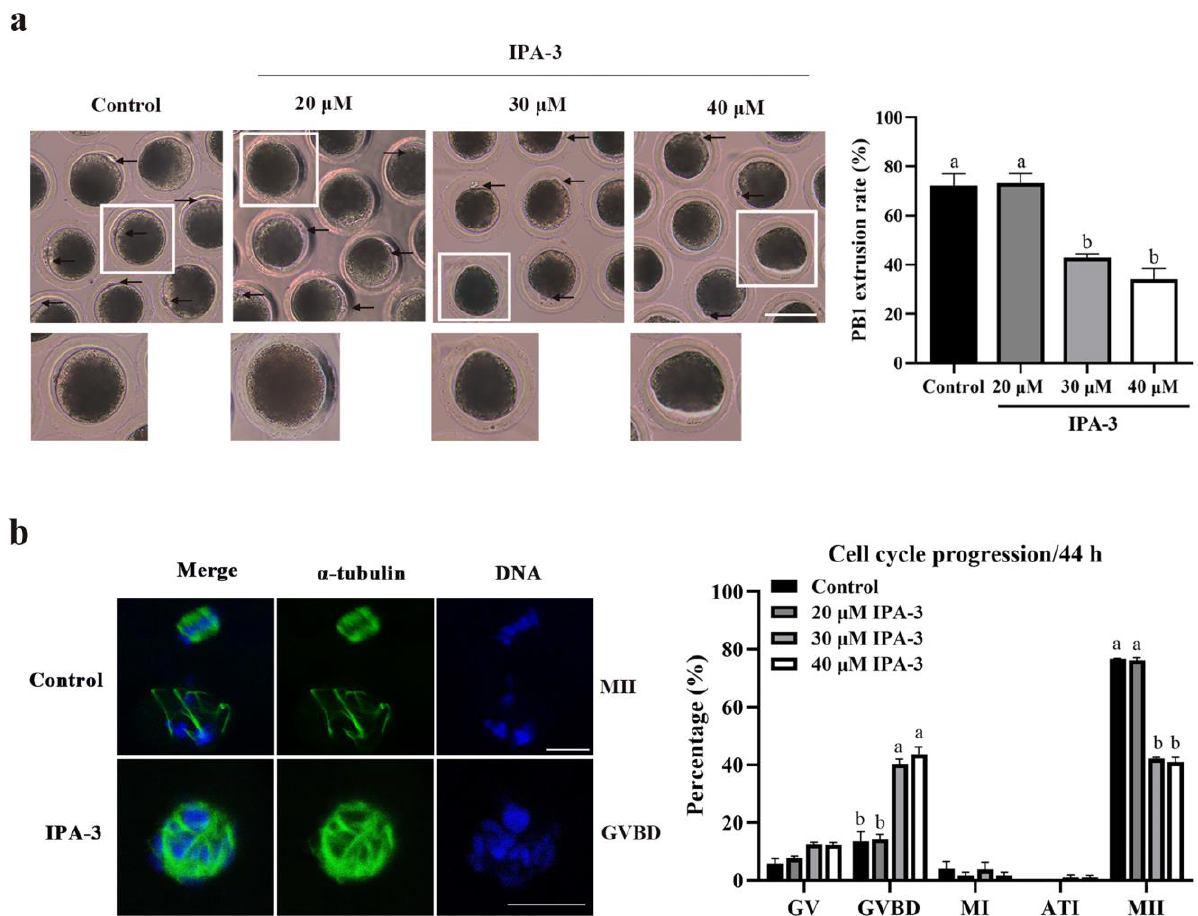
Figure 2. Effects of IPA-3 treatment on maturation and cell cycle progression of porcine oocytes. ( a ) Representative images of PB1 extrusion and PB1 extrusion rate in control and IPA-3 treated groups after 44 h of culture ( n = 104 for the control group; n = 105 for 20 µM IPA-3 group; n = 105 for 30 µM IPA-3 group; n = 105 for 40 µM IPA-3 group). Arrow, the PB1. Scale bars are 100 μm. ( b ) PAK1 inhibition disrupted the cell cycle progression of porcine oocytes ( n = 103 for the control group; n = 105 for 20 µM IPA-3 group; n = 104 for 30 µM IPA-3 group; n = 105 for 40 µM IPA-3 group). Green, α-tubulin. Blue, chromosome. Scale bars are 10 μm. a, b Values with different superscript letters above columns indicate significant differences ( p < 0.05). PB1, the first polar body; GVBD, germinal vesicle breakdown; MII, metaphase II.